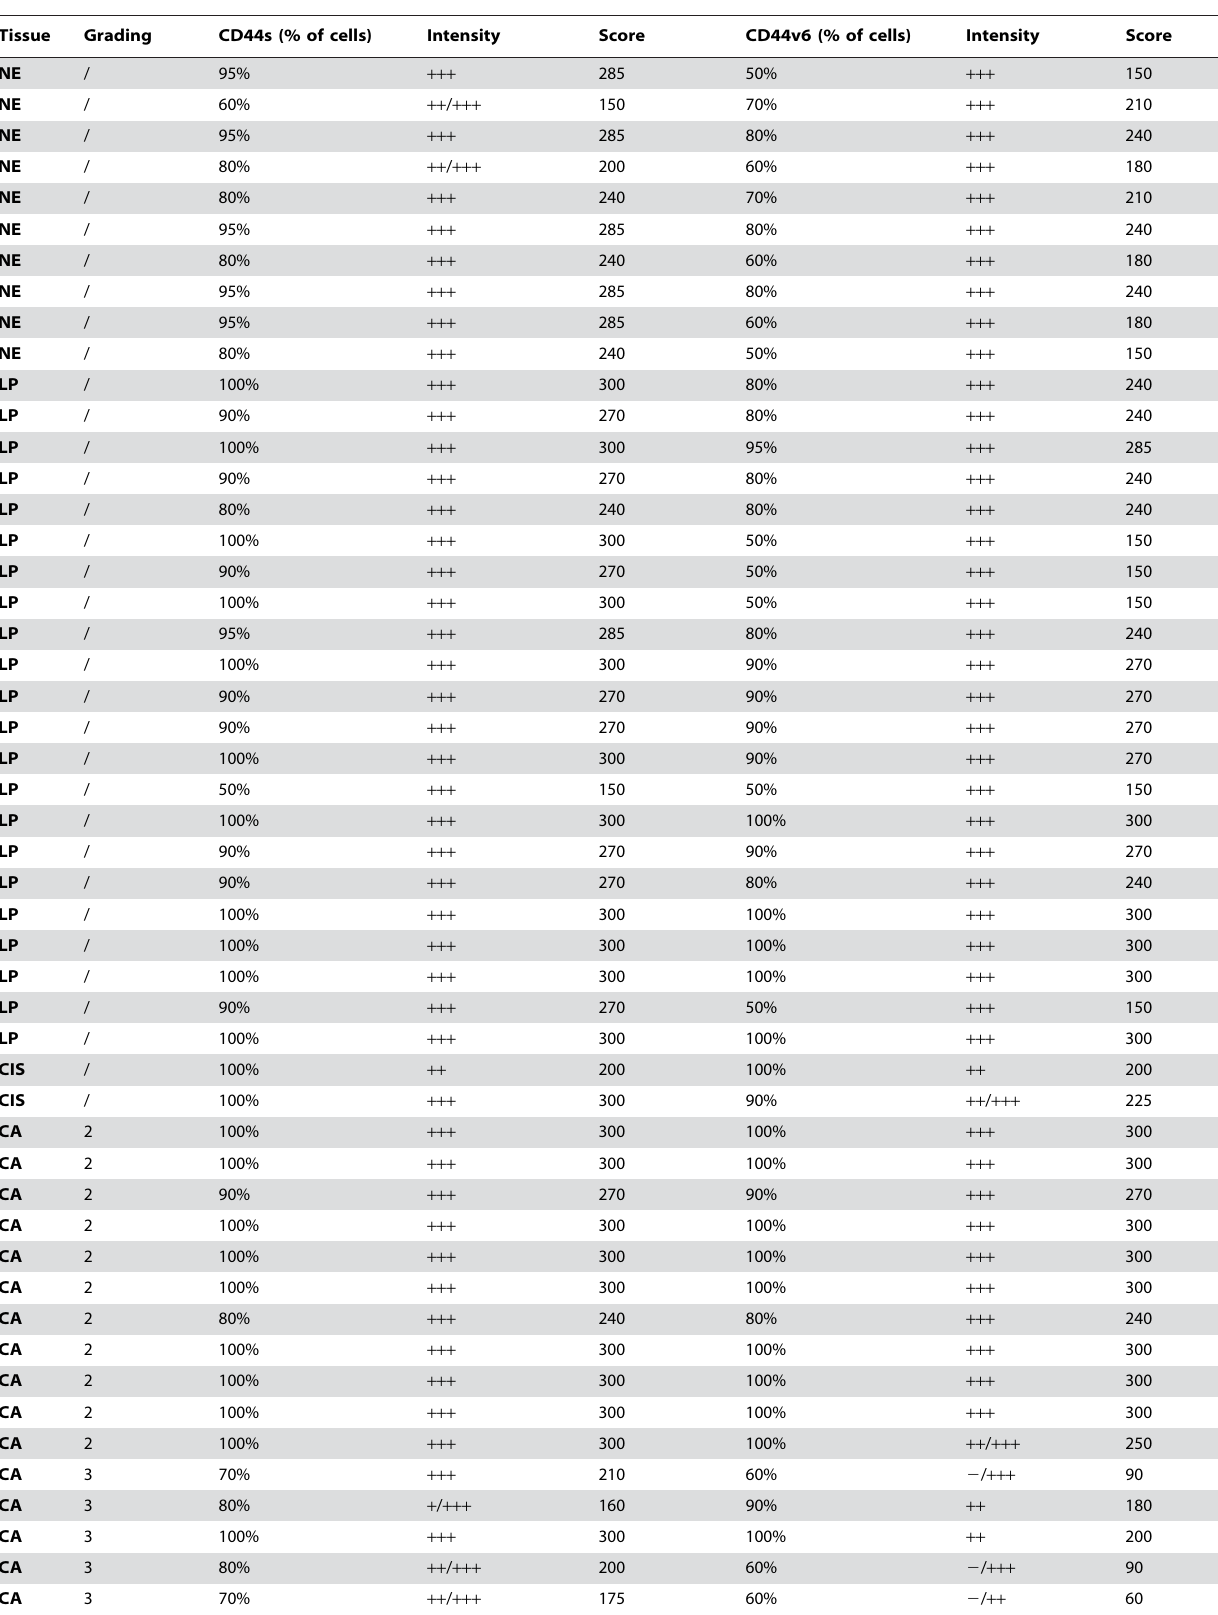
Table 1. CD44s and CD44v6 expression in normal epithelia (NE), carcinoma (CA), carcinoma in situ (CIS), and leukoplakia (LP).